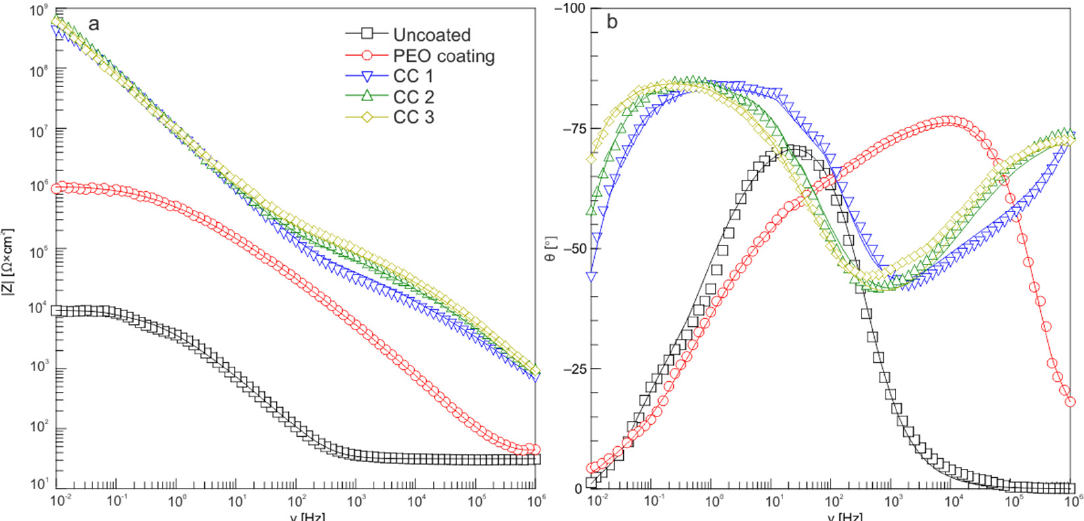
Figure 6. Bode plots (dependence of impedance modulus |Z| ( a ) and phase angle θ ( b ) on frequency) for samples made of AMg3 aluminum alloy with various types of surface treatment.